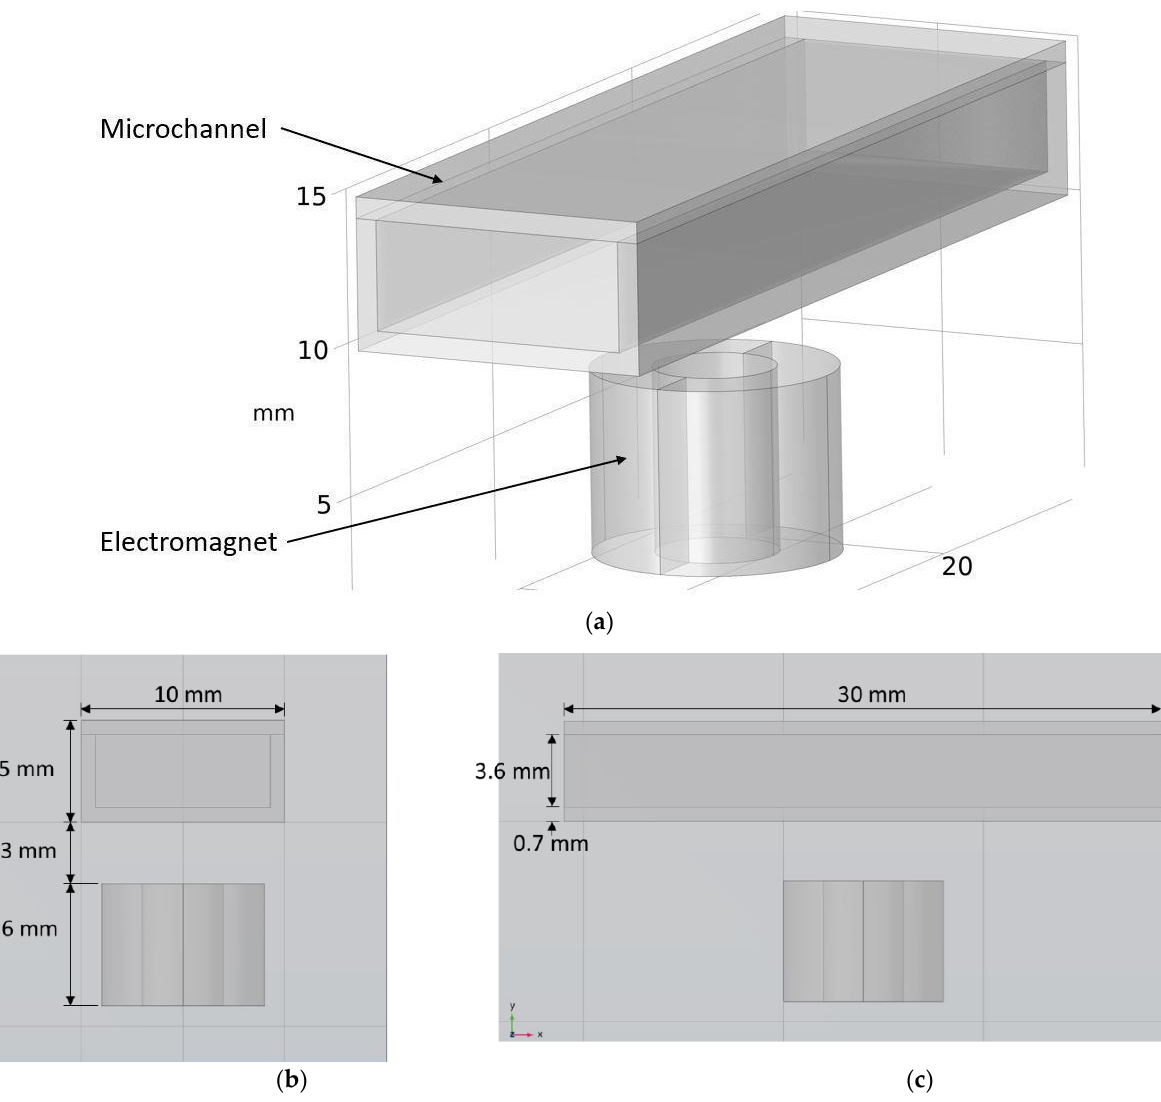
Figure 7. Schematic of the model studied in “Reprinted/adapted with permission from Ref. [18]. 2022, Rubayet Hassan” : ( a ) 3D view; ( b ) front view; and ( c ) side view.